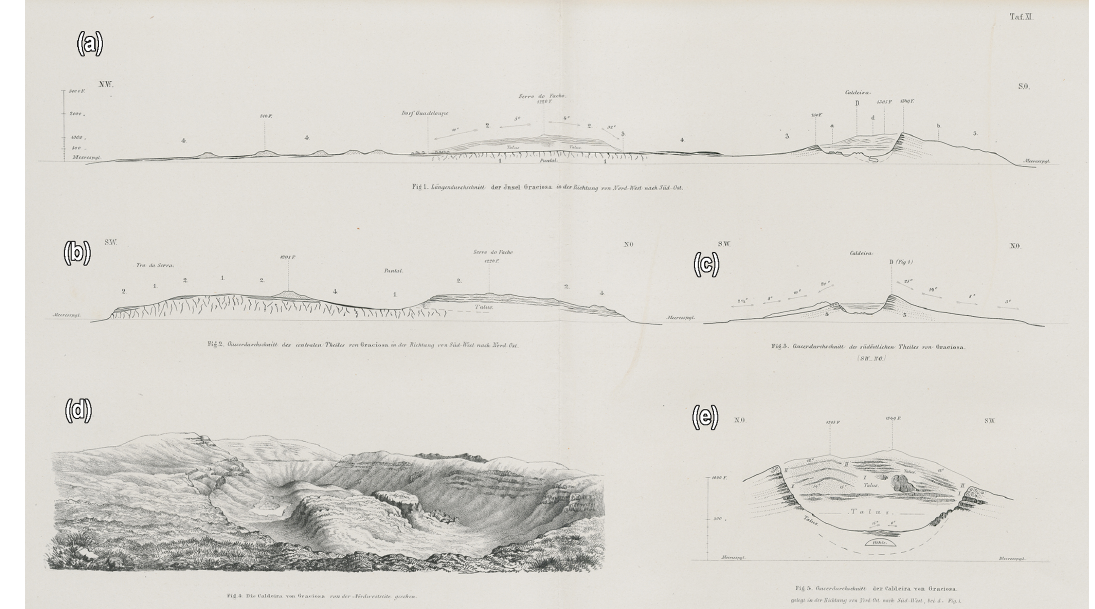
Figure 6. Hartung (1860a), plate XI, depicting geological sketches of Graciosa Island of the Azores archipelago. (a) NW–SE cross section of the island depicting the four main volcanic formations proposed by Hartung. (b) SW–NE cross section of the island. (c) SW–NE cross section of the southern part of the island, crossing the caldera of Graciosa. (d) A panorama of the caldera of Graciosa. (e) NE–SW cross section of the Graciosa caldera, signalling the Furnas do Enxofre (“hölhe” in the original). The image is public domain and was digitalized by ETH-Bibliothek Zurich (https://www.e-rara.ch/zut/content/zoom/7111423, last access: 26 September 2021).